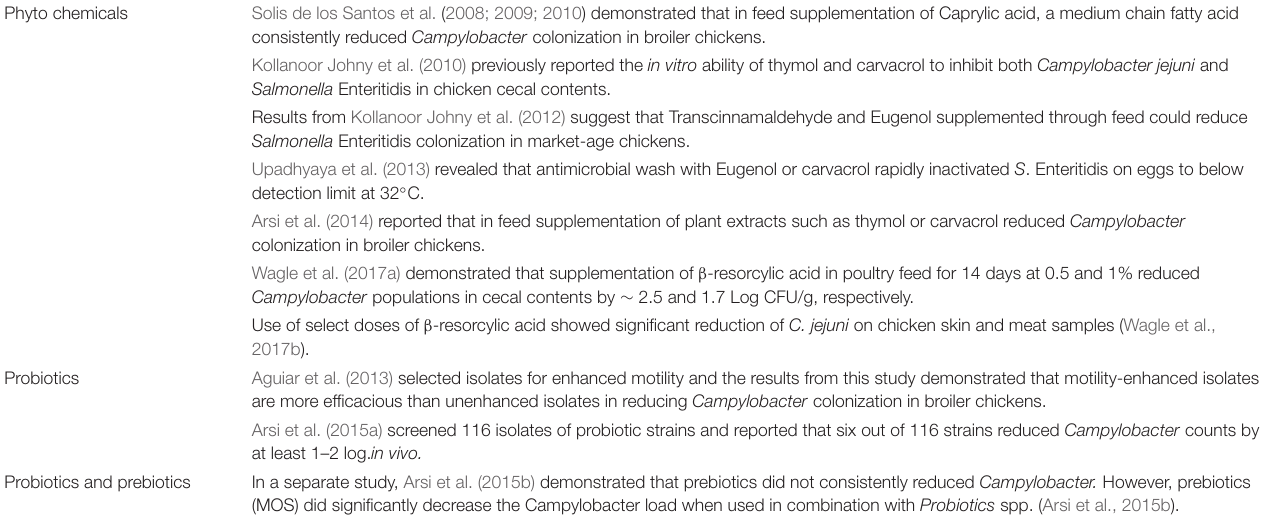
TABLE 2 | The efficacy of antibiotic alternatives (phyto chemicals, probiotics, and probiotics and prebiotics) on reducing Campylobacter colonization and counts in broilers. Phyto